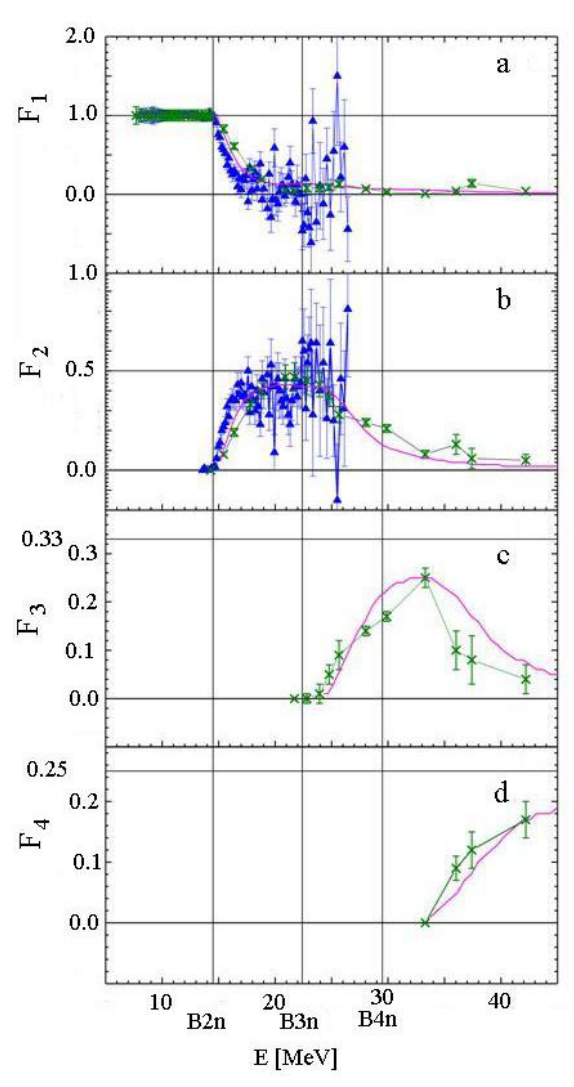
data for 209 Bi using the data obtained at Livermore Figure 1. F exp i ([16] - triangles) in comparison with calculated F theor